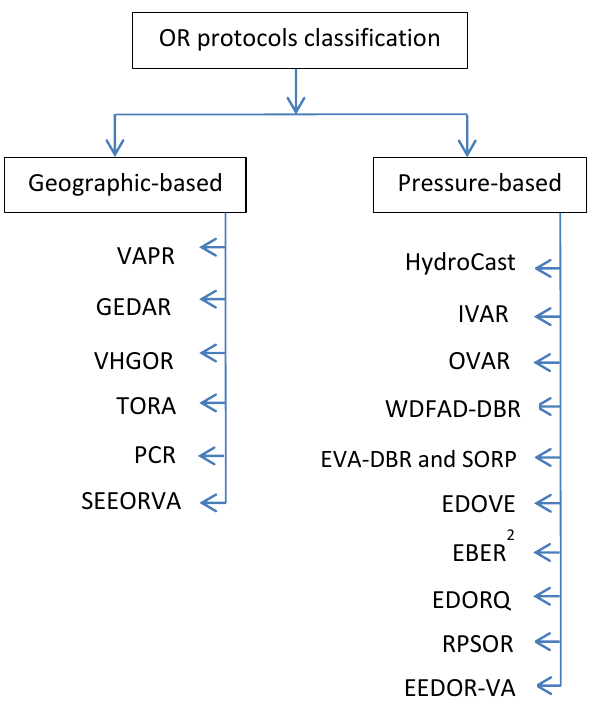
OR protocols classification